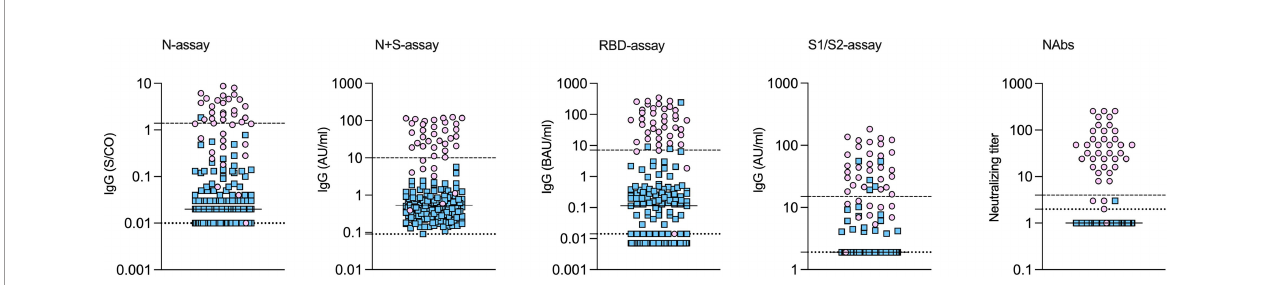
FIGURE 2 | SARS-CoV-2 speci fi c antibodies measured by different assays in health care workers with and without veri fi ed COVID-19. Health care workers with (pink circles) and without (blue squares) veri fi ed COVID-19. Concentrations of IgG measured by different commercial IgG-assays and by virus neutralization at time- point 4. Medians indicated by horizontal lines. The upper dashed lines indicate the cut-off for positivity, and the lower dotted lines indicate the lowest detectable concentration/index.